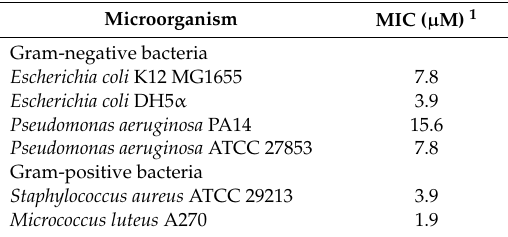
Table 1. Sarconesin II’s antibacterial activity spectrum.